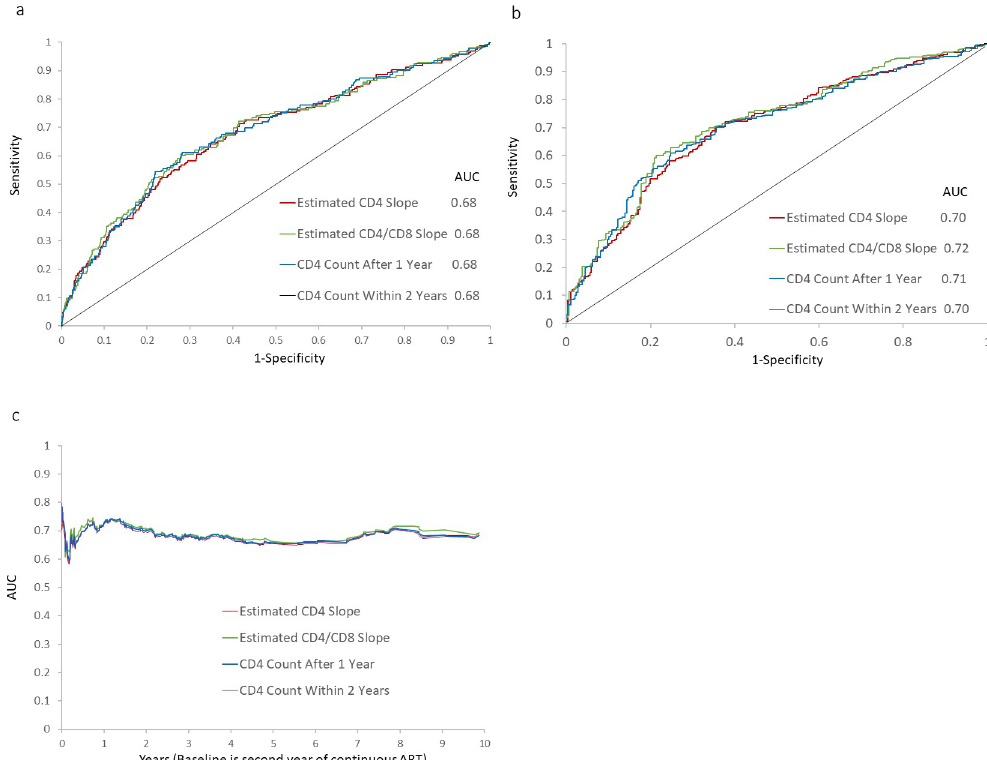
Fig 3. Time-dependent ROC curves at (3a) 5 and (3b) 10 years from ART initiation and (3c) time-dependent AUCs evaluated over the 10-year study period (baseline at second year of continuous ART). Cox regression models include (i) Estimated CD4 slope (ii) Estimated CD4/CD8 ratio slope (iii) CD4 counts after 1 year and (iv) CD4 counts after 2 years as main predictors, respectively, and adjusted for estimated CD4 intercept or estimated CD4/CD8 ratio or baseline CD4